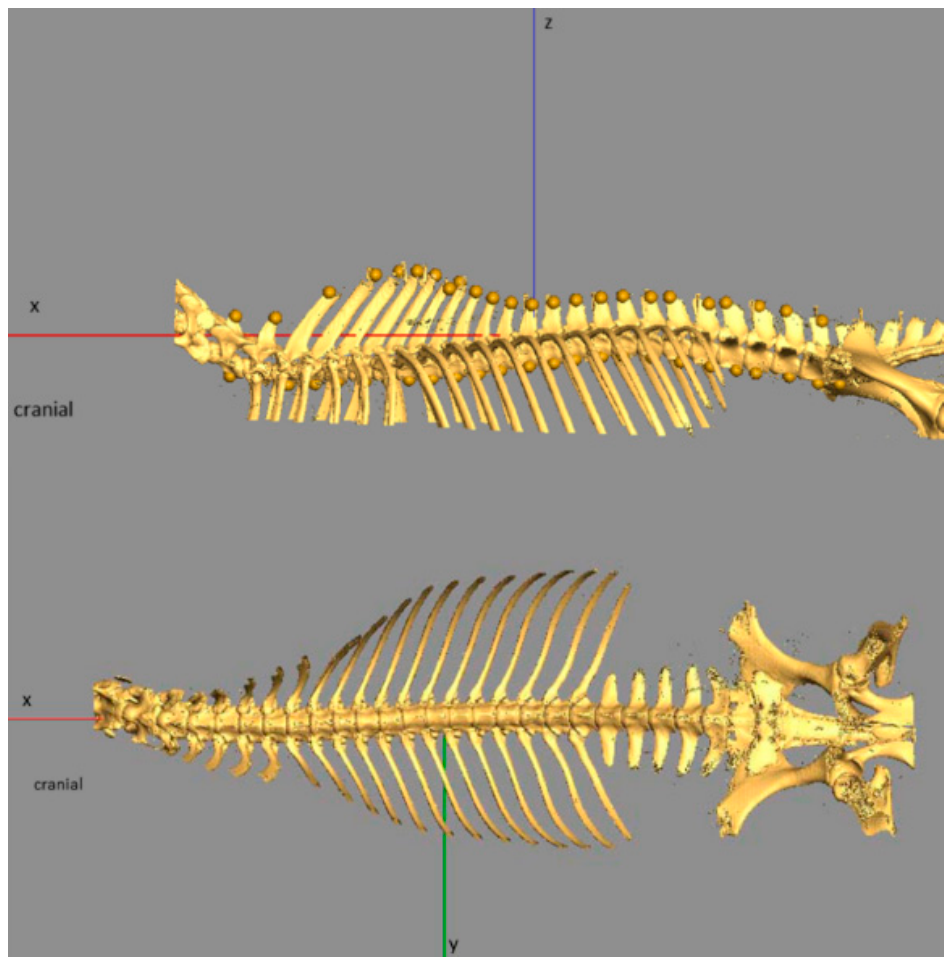
Figure 1. Dorsal and left lateral view of the rendered three-dimensional skeleton model of a horse back. Neck region removed cranial to the 6th vertebra, thoracic and lumbar ribs reduced to dorsal aspects, bones of the pelvic limbs removed distal to the hip bone and caudal bones removed. Models of the skeleton were aligned according to a standardised reference coordinate system as described above. The x -axis was defined as cranio-caudal axis, the y -axis as left–right axis and the z -axis as dorsoventral axis.